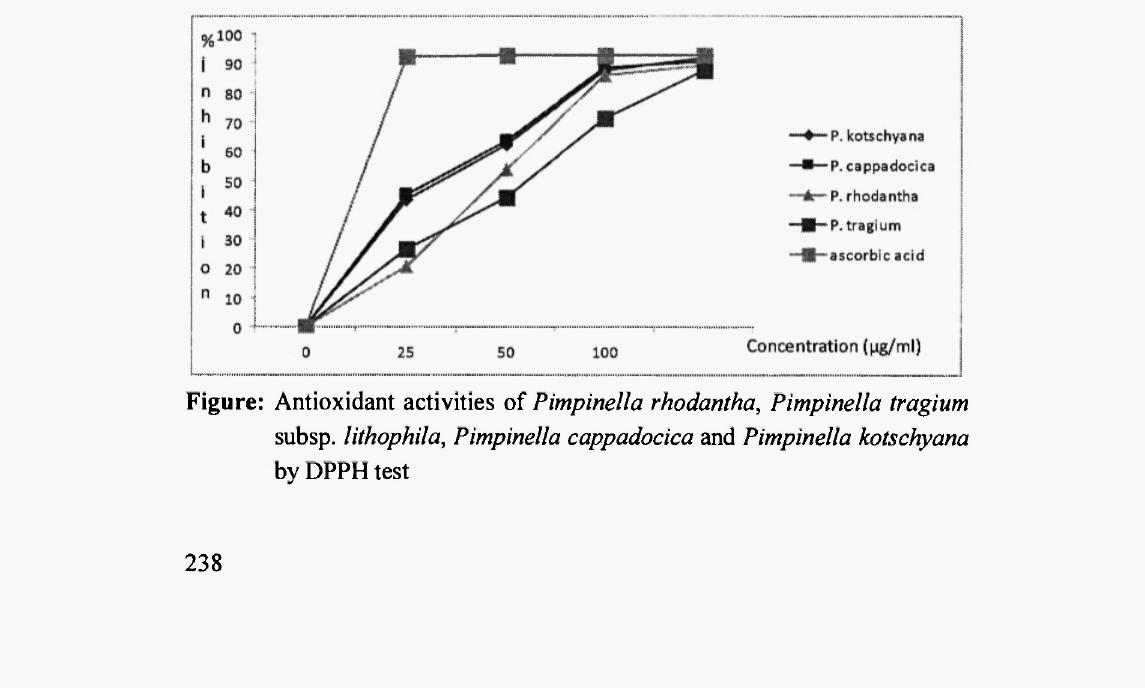
Figure: Antioxidant activities of Pimpinella rhodantha, Pimpinella tragium subsp. lithophila, Pimpinella cappadocica and Pimpinella